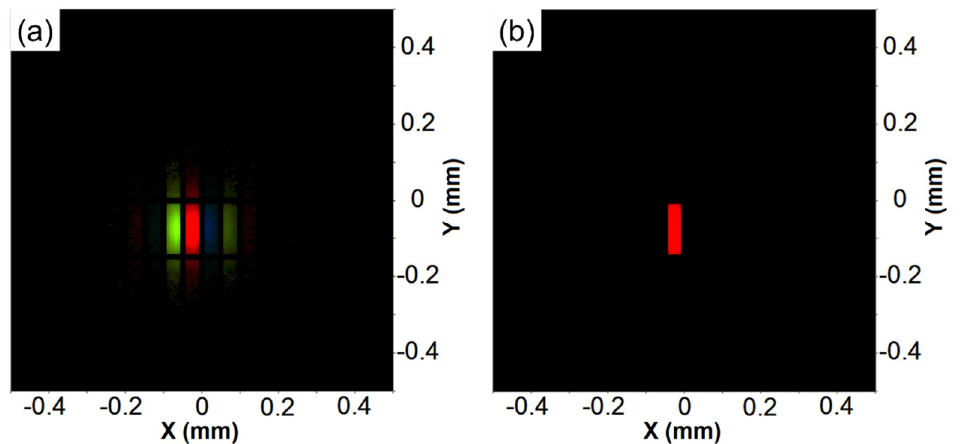
Figure 4. Simulated color images of ( a ) device A and ( b ) device B when only one red subpixel is turned on, while green and blue subpixels remain off.